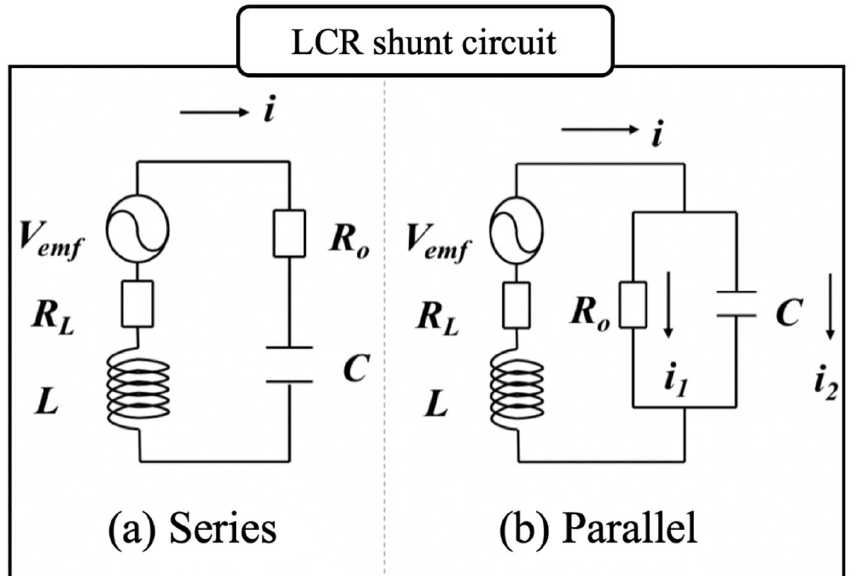
Figure 1. Analytical model of superconducting levitation system with an electromagnetic shunt damper.